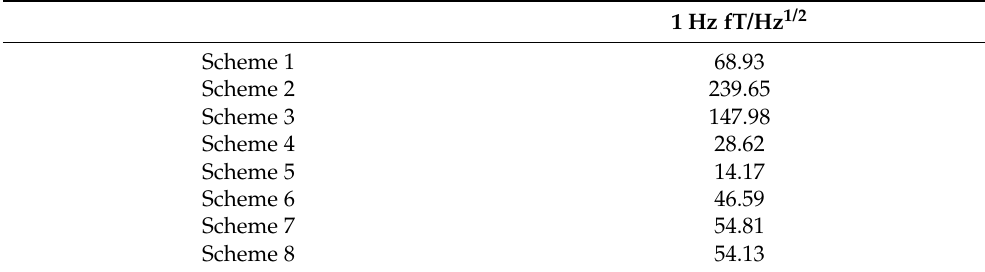
Table 2. Magnetic noise value of schemes 1–8 at 1